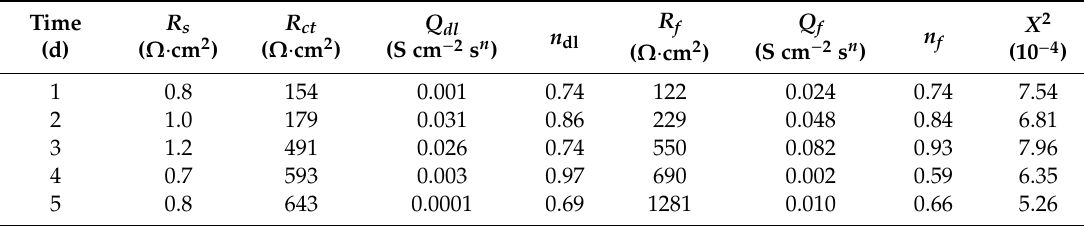
Figure 7. The equivalent electric circuit used to fit the impedance data. Table 4. Impedance parameters obtained on the 12Cr1MoV steel electrode after corroded different time in TCSA solution.